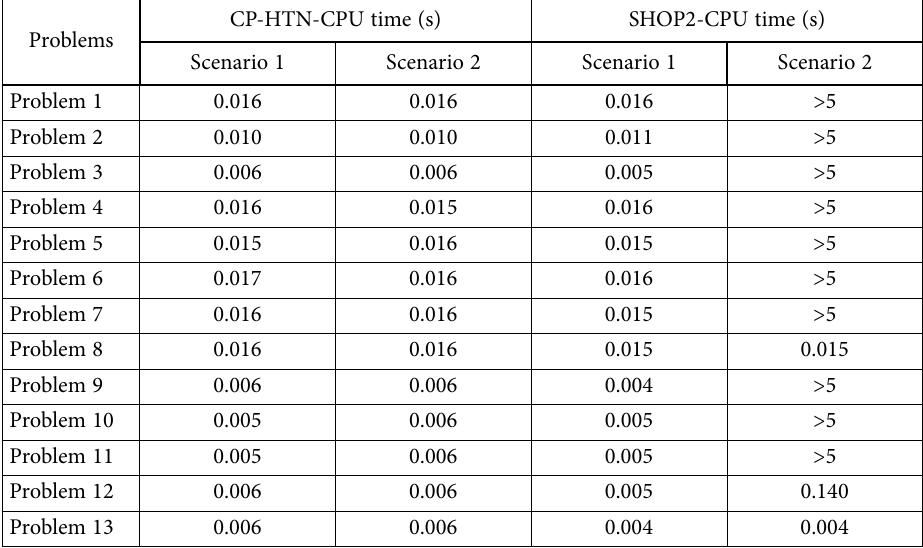
Table 7. Comparison results of CP-HTN and